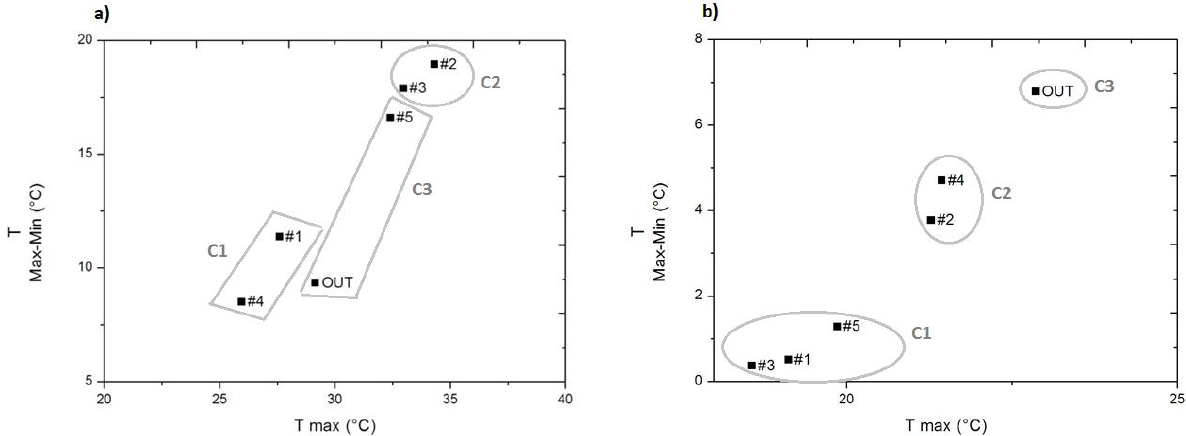
Figure 8. Bivariate plot of maximum temperature (T Max) versus mean daily variation of temperature (T Max-Min): ( a ) from 25 July 2013 to 12 August 2013, from 00.00 to 23.59 h (864 data points/sensor); ( b ) from 13 August 2013 to 8 October 2013, from 00.00 to 23.59 h (2,688 data